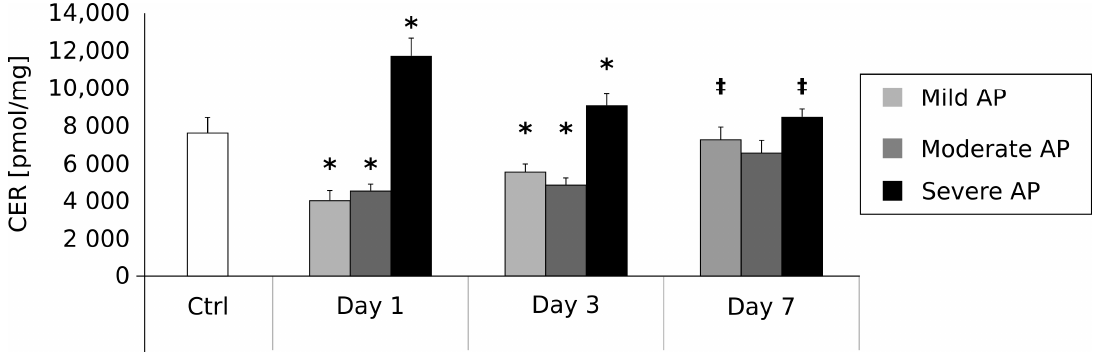
Figure 2. Alterations in ceramide (CER) concentrations (pmol/mg) in the course of acute pancreatitis. * = difference vs. Control, p < 0.05; ‡ = difference vs. Day 1, p <